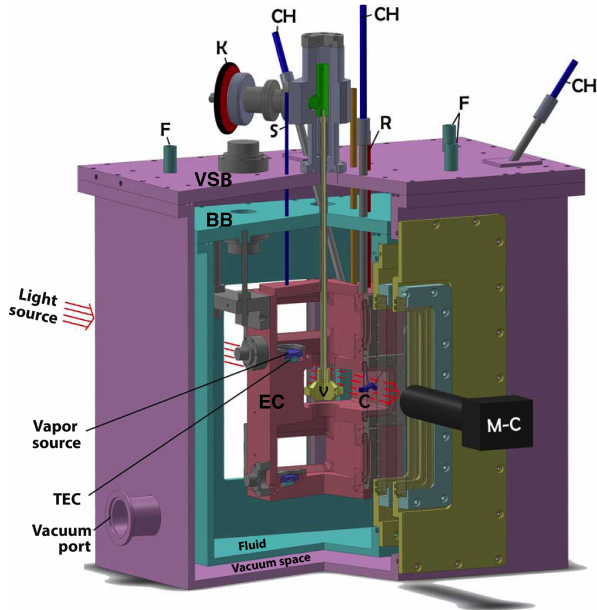
Figure 1. Cutaway of the triple-capillary cryostat (CC2). Both the (turquoise) bath box (BB) and (purple) vacuum-shroud box (VSB) surround the (red) experimental chamber (EC). The growth cham- ber (GC) is the middle chamber in the EC where the crystals (C) are located. The top and bottom chambers are the two vapor-source chambers (VSCs) each containing a vapor source (VS) situated on a thermoelectric cooler (TEC). The setting of sliding valve (V) de- termines which VS sets the humidity in the GC. Other features are capillary holders (CH), cryogenic-fluid tubing (F), knob for sliding valve (K), tubing for filling vapor-source holders and for monitor- ing VSC pressure (S and R), and SLR camera with telemicroscopic lens (M-C). Three sets of silica windows separate the laboratory air and the inside of the GC. For dimensions, the EC is 7in. high and the CH tubes are 0.25in.